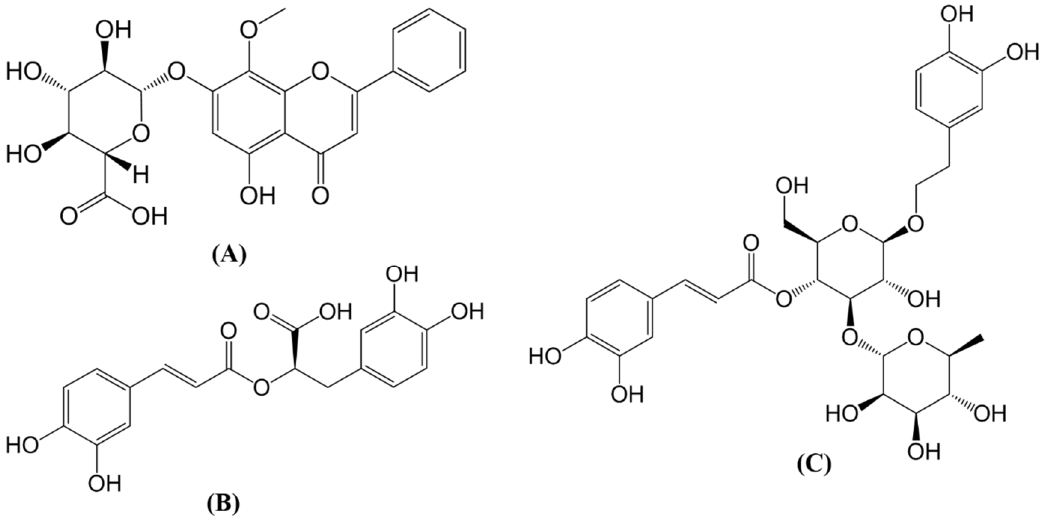
Figure 2. Chemical structures of ( A ) oroxindin, ( B ) verbascoside and ( C ) rosmarinic acid.